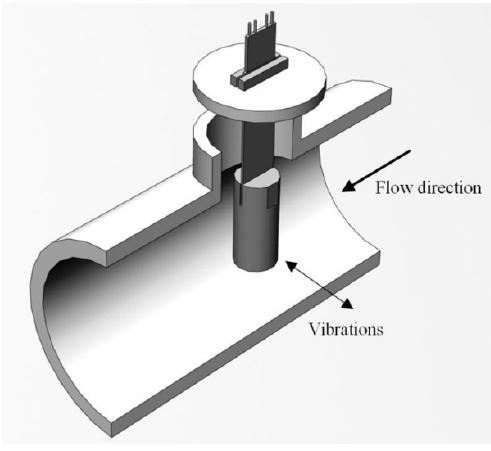
Figure 1. Energy harvester assembly on a pipe (not to scale).